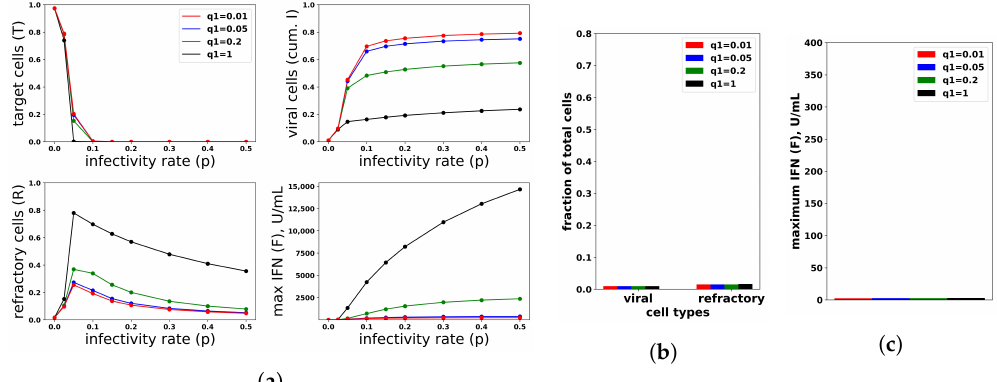
Figure 8. An increasing IFN secretion rate can simultaneously protect against high infectivity viruses and avoid excessive IFN secretion against low infectivity viruses. This figure is analogous to Figure 7, except that an increasing secretion rate is assumed. Each colored curve and bar correspond to a different value of q 1 (see legend), and we fixed q 0 = 0.01. Compare Panels ( b , c ) of this figure and Figure 7. See Figure 7 for further